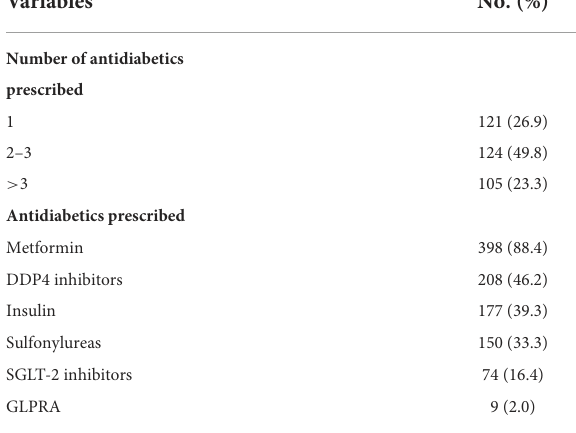
TABLE 2 Sociodemographic and clinical characteristics of